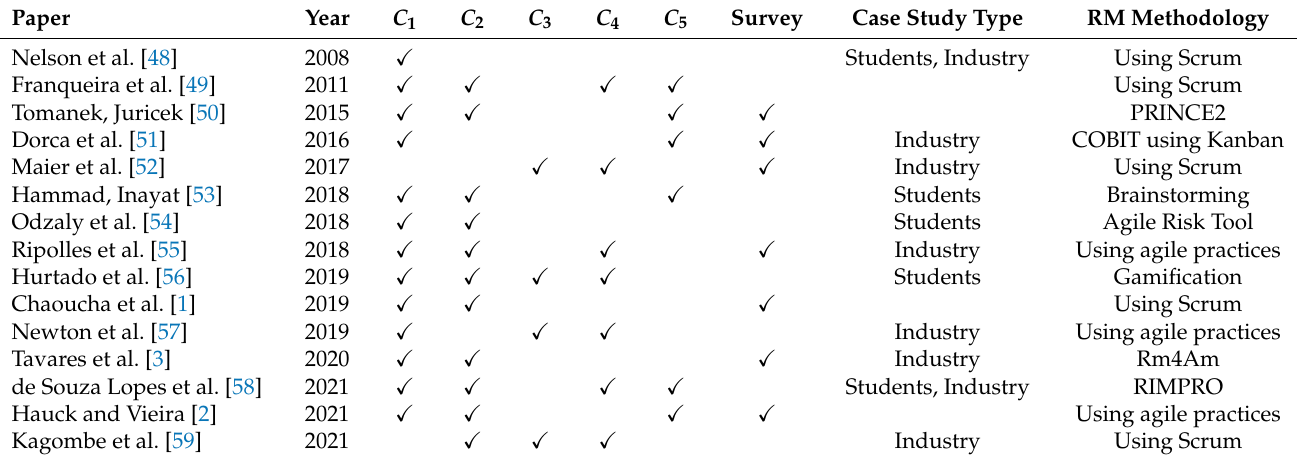
Table 1. Overview of articles reviewed where the C n columns shows which of the cybersecurity related challenges have been addressed, the survey column indicates if the study is validated with a survey study, case study type is either with students or professionals and RM methodology the used